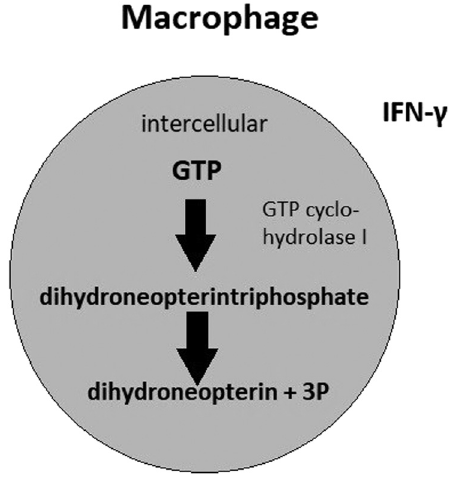
Figure 1: Synthesis of neopterin. Neopterin and its derivatives are synthesized in macrophages from GTP by the enzyme GTP - CH. The GTP - CH activity is induced by interferon - γ